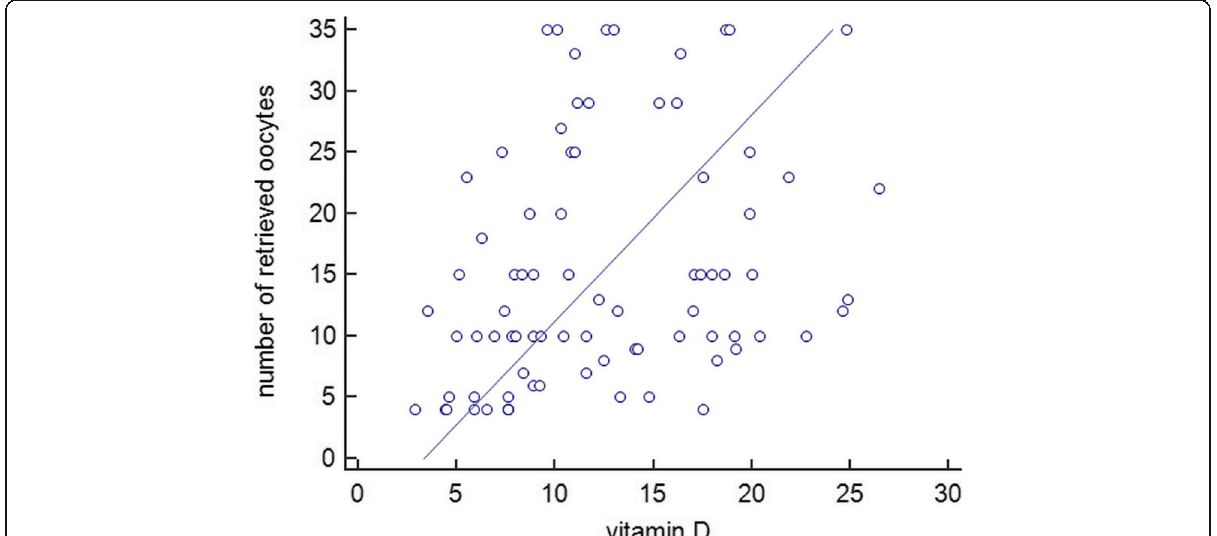
Fig. 2 Correlation of serum 25 (OH) D vitamin level to the number of retrieved